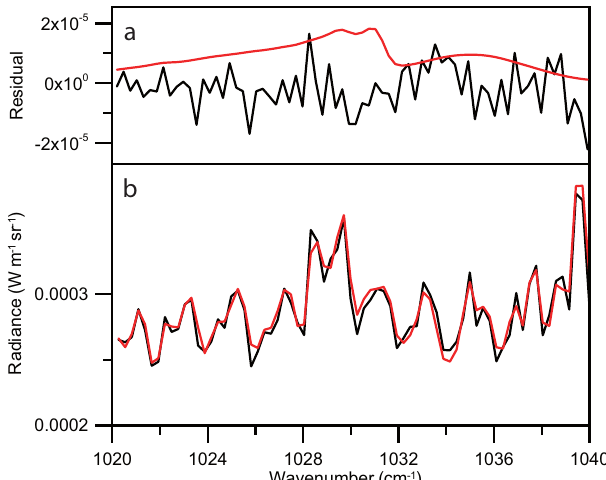
Fig. 5. Thermal emission spectrum (below) in the region used for analyzing SiF 4 . The black trace is the measured spectrum in the position of B depicted in Fig. 1, and the red trace corresponds to the fitted simulation. The fit residual (above) is shown in black together with a forward simulation of SiF 4 alone with the fitted result of 4.5 × 10 15 moleccm − 2 .